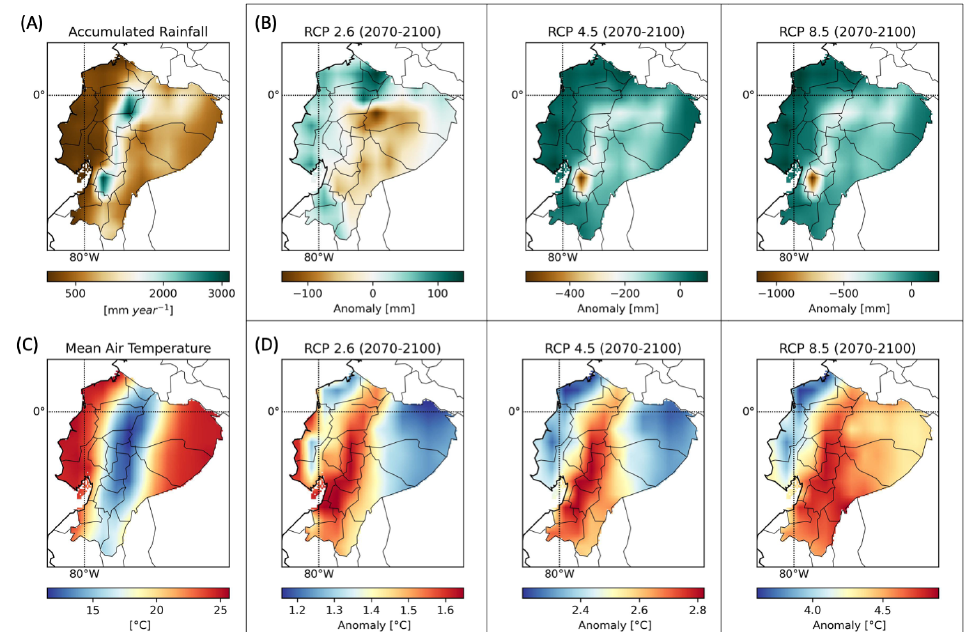
Figure 2. Annual precipitation ( A ) and mean air temperature ( C ) climatology. Seasonal mean change in ( B ) rainfall (%) and ( D ) mean air temperature with respect to the base period (1975–2005) predicted based on RegCM4 daily weather for 2070–2100 under RCP 2.6, 4.5, and 8.5 scenarios.